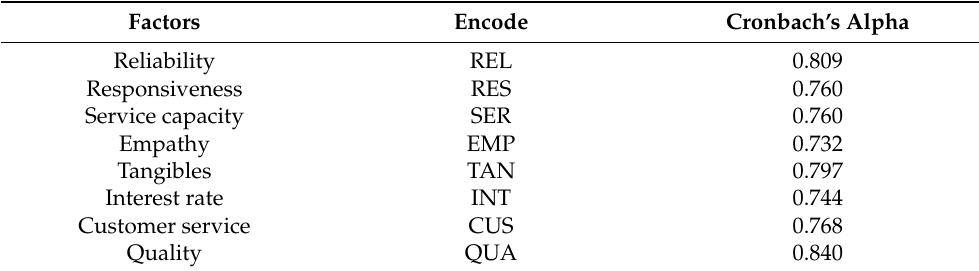
Table 2. Cronbach’s Alpha